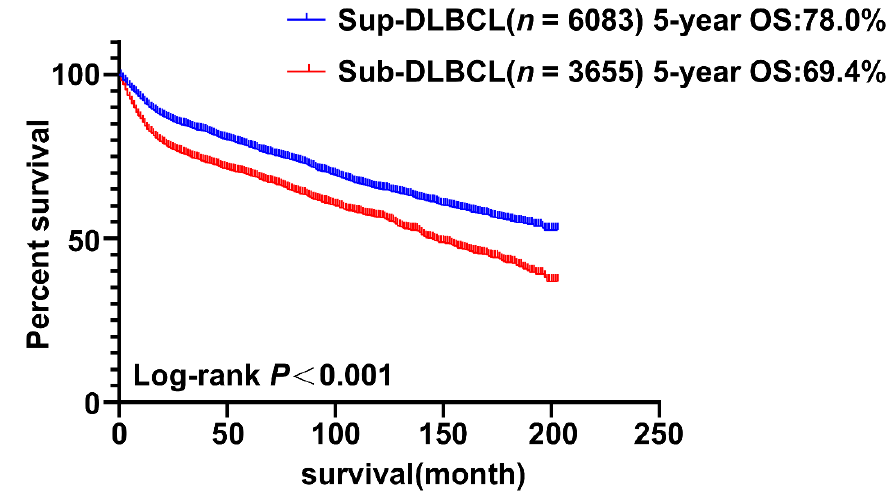
Figure 2. Kaplan–Meier curves of overall survival for patients with diffuse large B-cell lymphoma